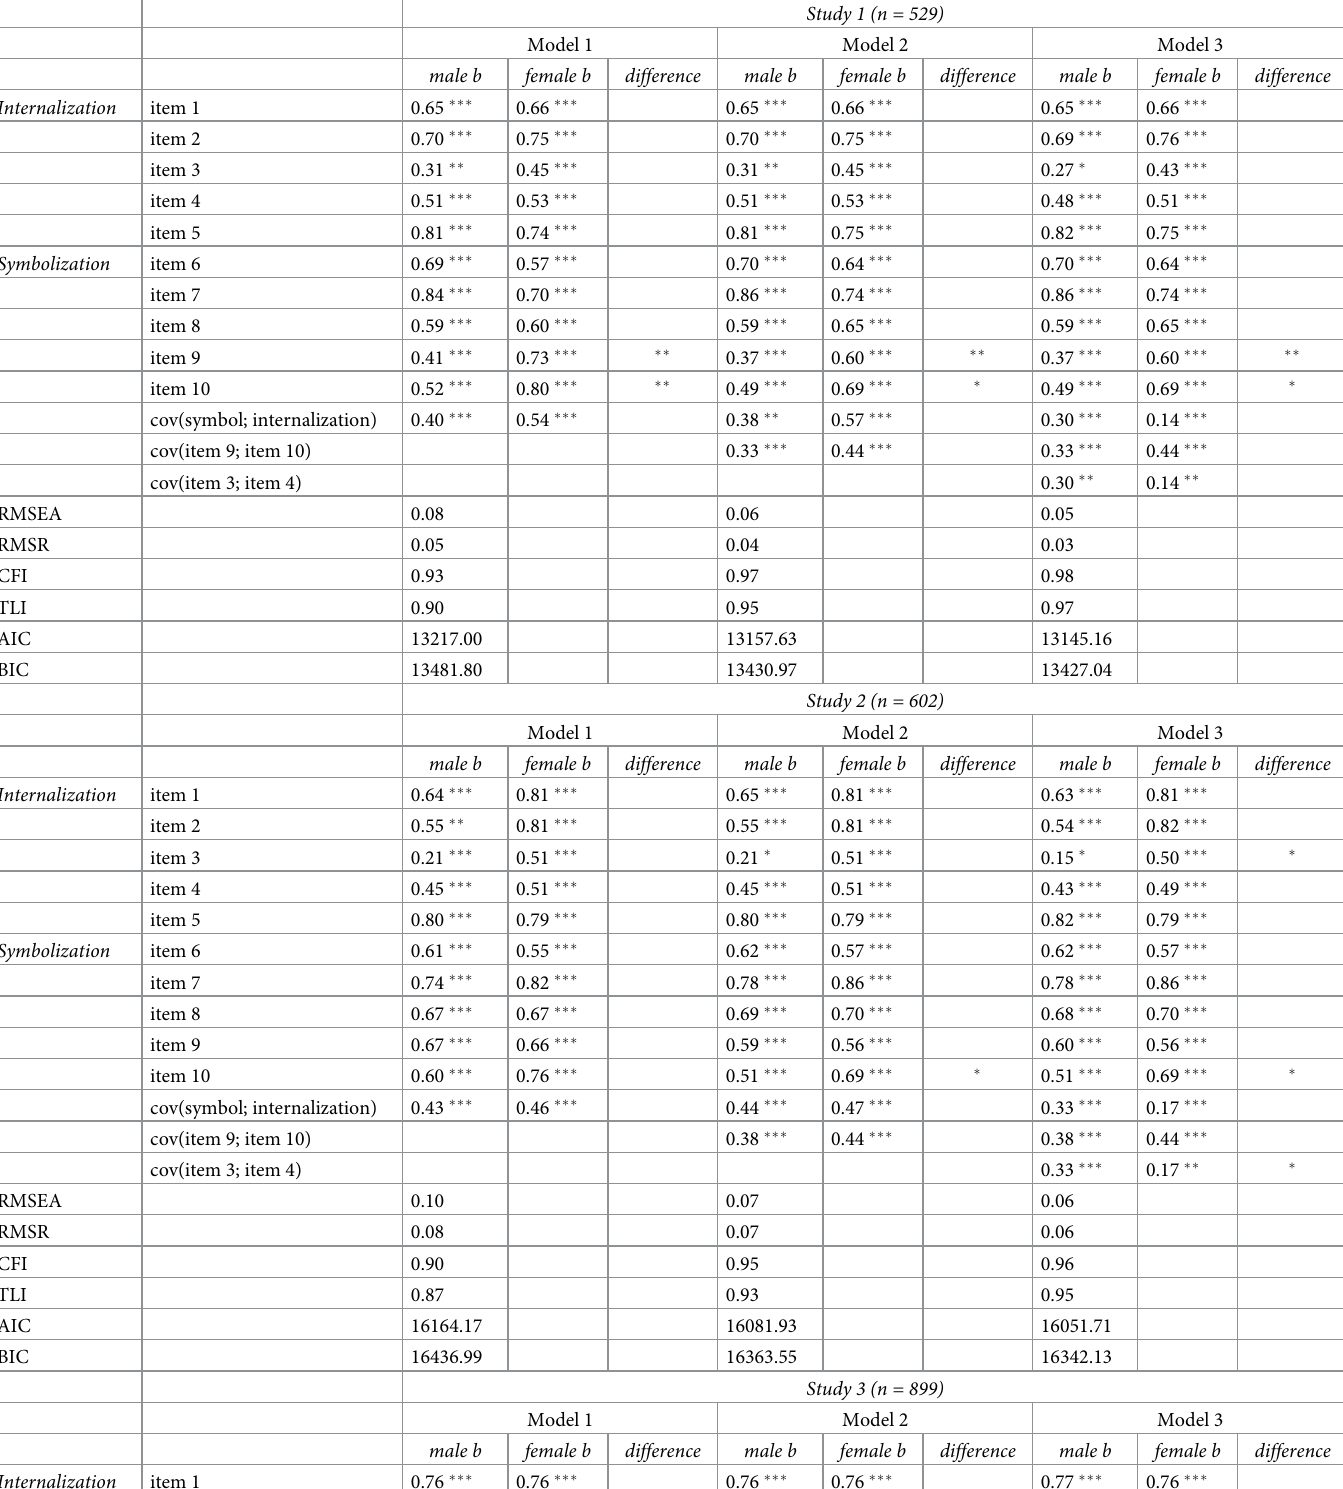
Table 5. Standardized coefficients of multigroup Confirmatory Factor Analysis (CFA) of SMIS items across gender in Studies